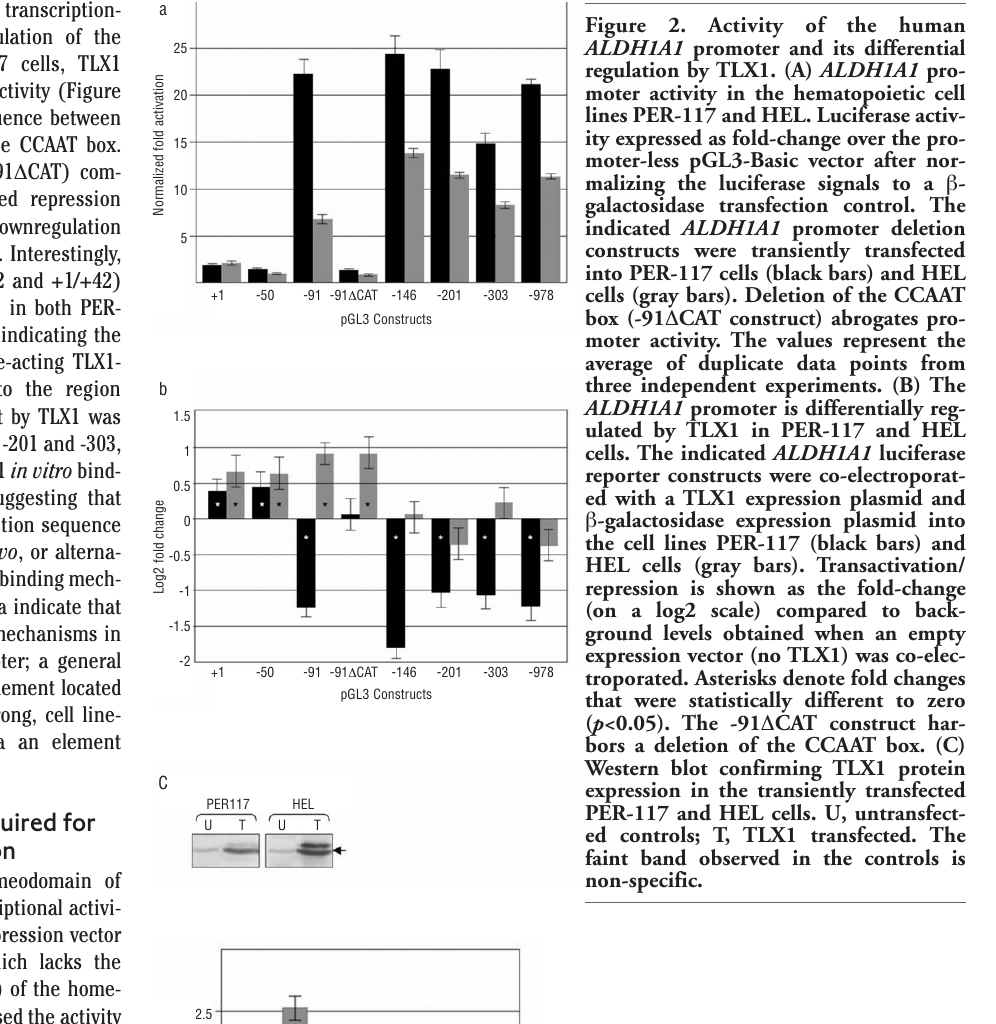
Figure 3. TLX1 requires an intact home- odomain for transcriptional repression but not activation in vitro . Luciferase activity of the ALDH1A1 -91/+42 and FHL1 -821/+181 promoter constructs cotransfected into the indicated cell lines with either an empty expression vector as negative control (striped bars), TLX1 (black bars) or TLX1 Δ H3, a mutant lack- ing helix 3 of the homeodomain (gray bars). The values represent the average of duplicate data points from three inde- pendent